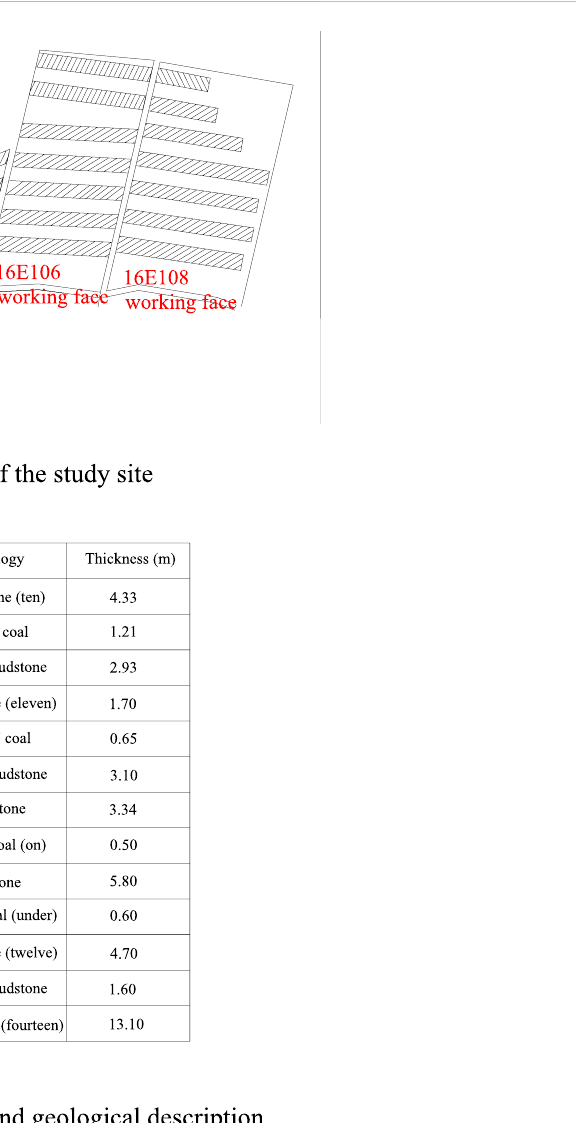
FIGURE 3 Panellayoutofthestudy siteand coal stratadistributionand geological description, (A) Panellayout of thestudy site, (B) Coal strata distribution and geological